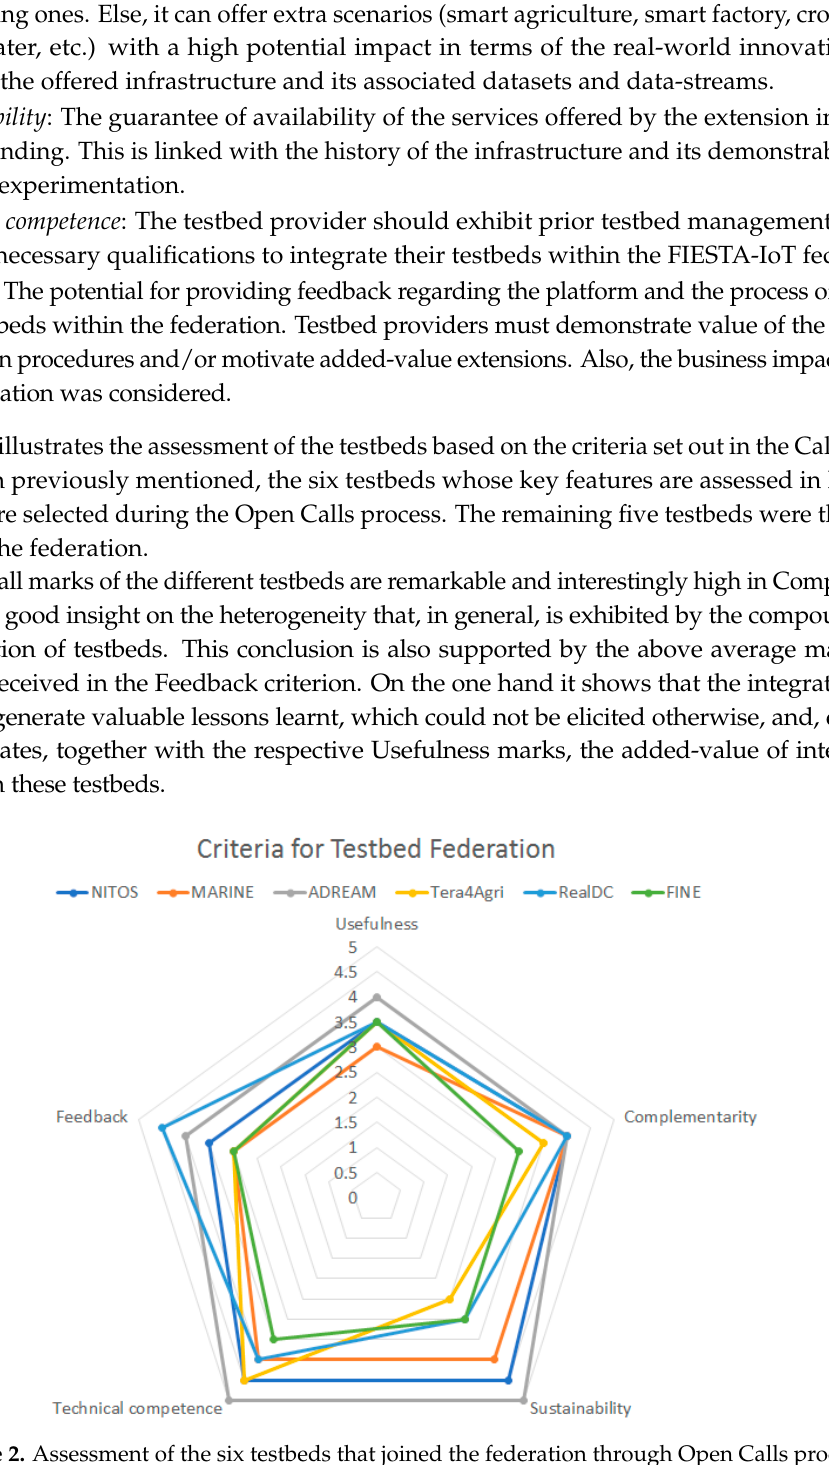
Figure 2. Assessment of the six testbeds that joined the federation through Open Calls process.